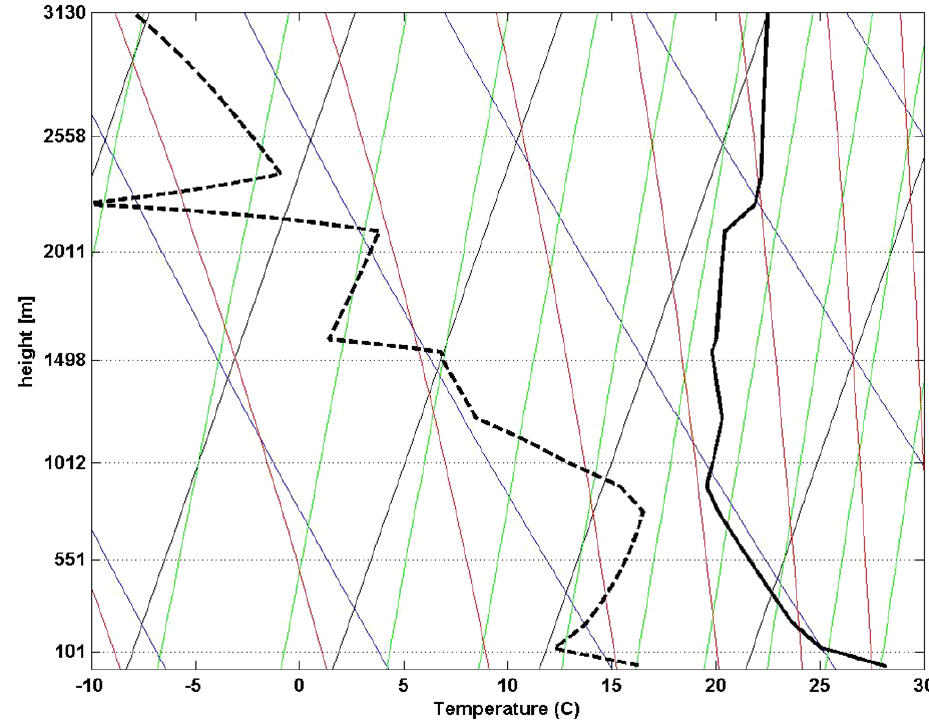
Figure B1. Tephigram of the atmospheric profile used in the